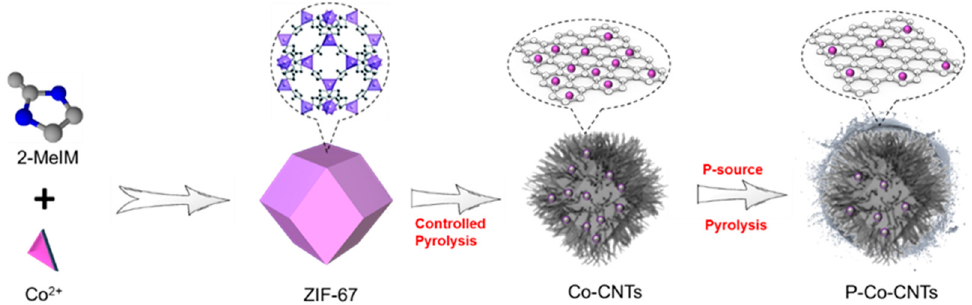
Scheme 1. Schematic representation of synthesis procedure for P-Co-CNTs nanostructure.